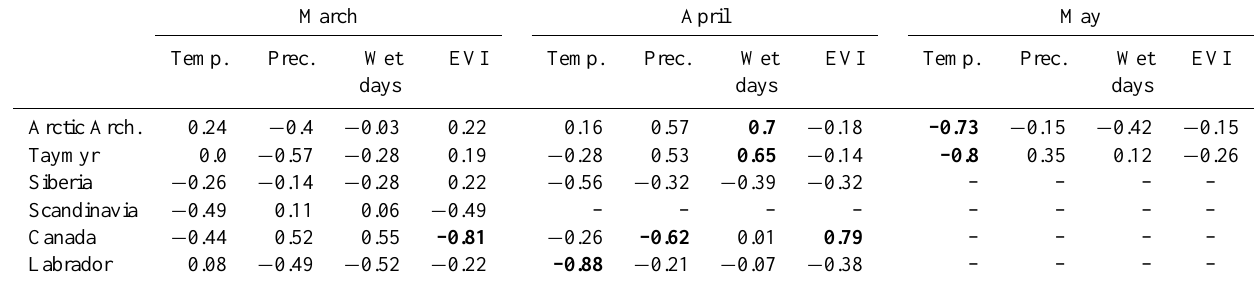
Table 1. Spearman correlation coefficients corresponding to the values presented in Fig. 5. Prec. represents precipitation; temp. represents temperature; EVI represents the Enhanced Vegetation Index. Correlation coefficients with corresponding p value < 0.05 are shown in bold. March April May Temp. Prec. Wet EVI Temp. Prec. Wet EVI Temp. Prec. days days days Arctic Arch. 0.24 − 0.4 Taymyr Siberia − 0.26 Scandinavia